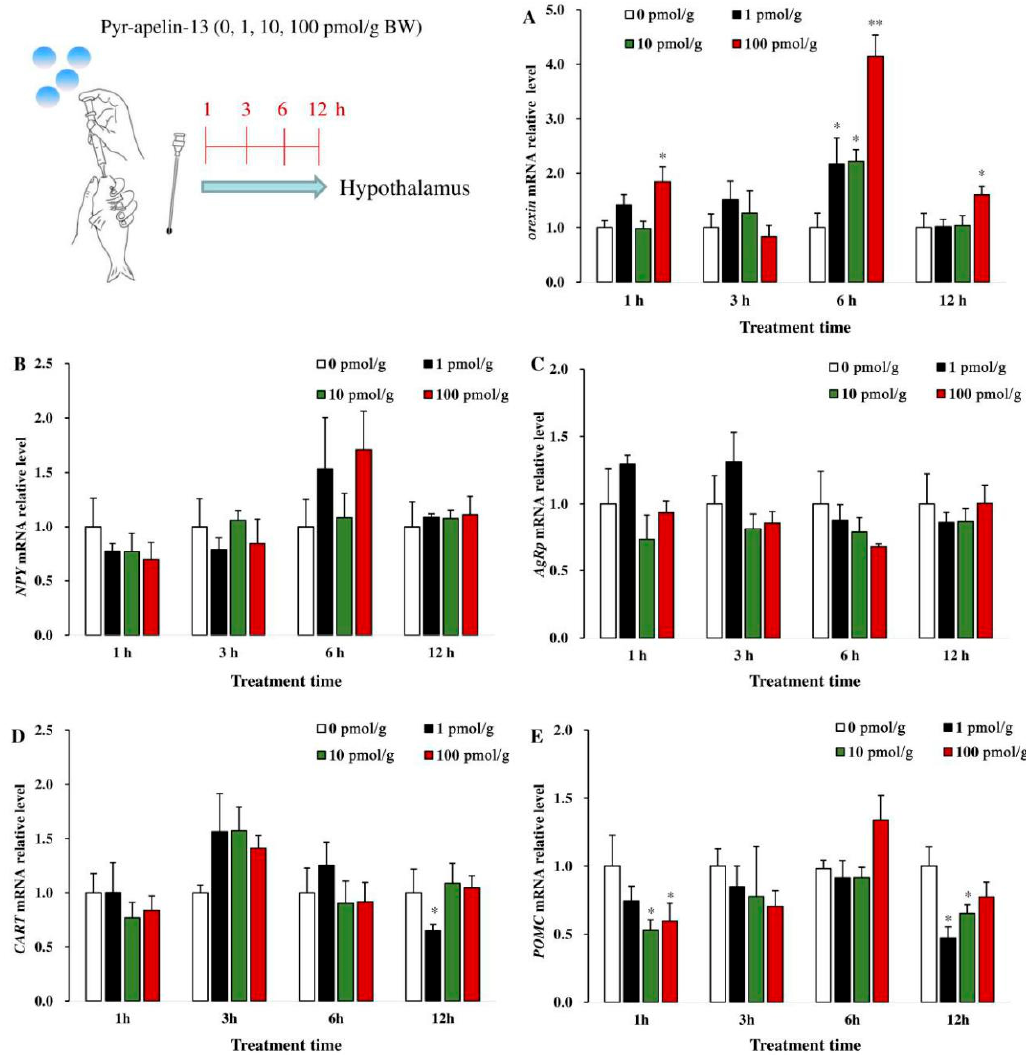
Figure 2. Gene expressions of appetite-related factors in the hypothalamus of Cyprinus carpio L. after gavage of Pyr-apelin-13 (0, 10, 100, and 1000 pmol/g). Orexin ( A ), NPY ( B ), AgRP ( C ), CART ( D ), POMC ( E ). Differences between treatment and control groups at each time point were tested with Duncan’s multiple range test, and are indicated by different asterisks (* p < 0.05, ** p < 0.01). The data were given as mean ± SEM. ( n = 6).